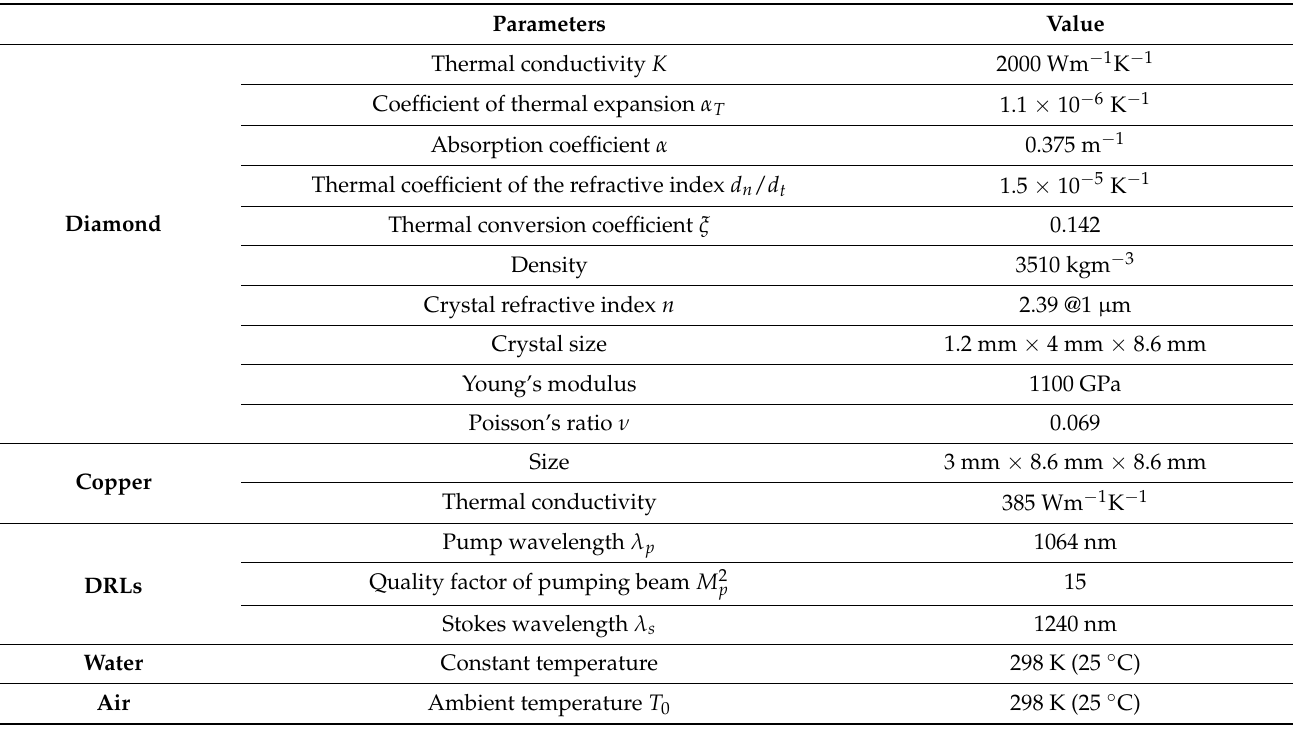
Table 1. Parameters used in